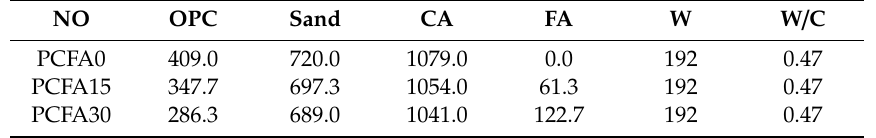
Table 1. Mix proportions of concrete. kg / m 3 .